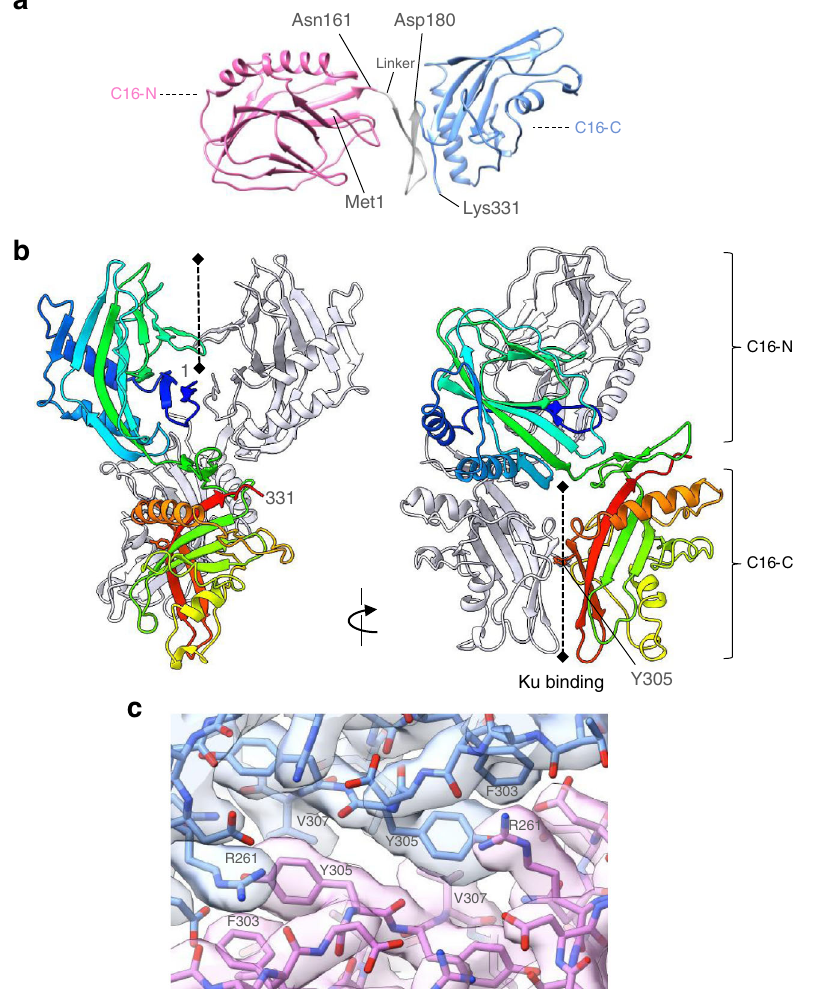
Fig. 3 | Structure of vaccinia virus C16 protein. a Boundaries between the N-terminal (pink colour) and C-terminal domain (light blue colour), of C16 repre- sented as ribbons. The two domains are connected by a fl exible linker. b Ribbon diagram of C16 dimer rainbow coloured (N-blue → C-red). The position of the fi rst and last residue is indicated. C16 N-terminal domain has structural homology to PHD2 22 and contains a three-layer β - β - α sandwich domain. The C-terminal domain of vaccinia C16 has an α - β - α sandwich architecture consisting of a highly curved